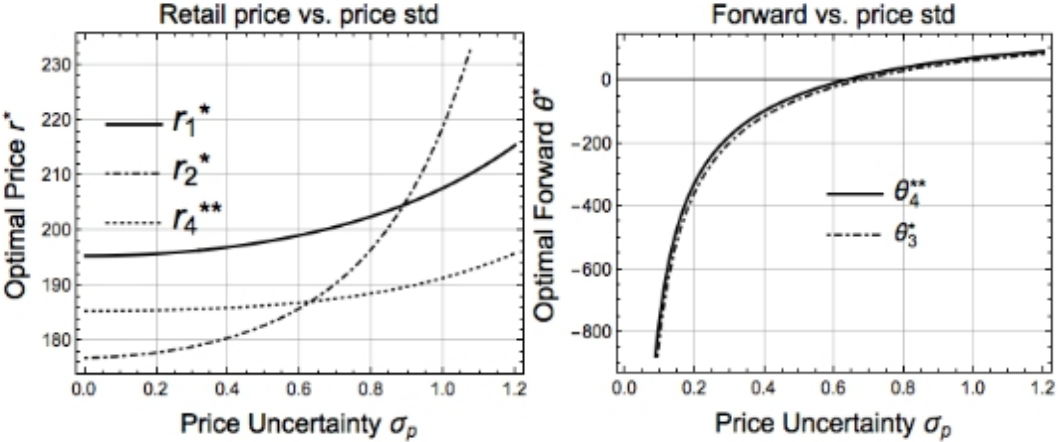
Figure 9. Comparison of r ∗ , r ∗ , and r ∗∗ from Theorems 1, 2, and 4 as a function of price uncertainty σ p (left panel), and θ and θ ∗ as from Theorems 4 and 3 as a function of price uncertainty σ p (right panel). The retail price of models 1 and 3 are identical by definition, so we only give the retail price of model 1. All other parameters were set according to the benchmark setup as given in Table 2.